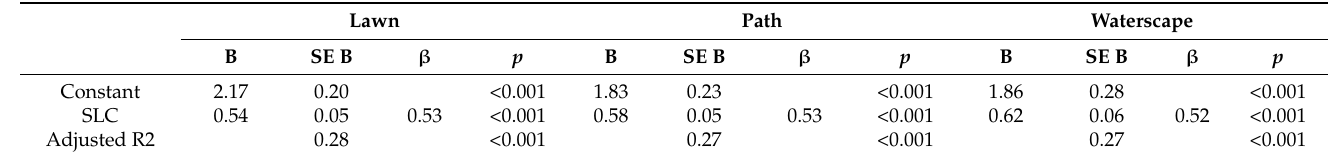
Table 5. Regression results for the effect of landscape complexity on preference. Lawn